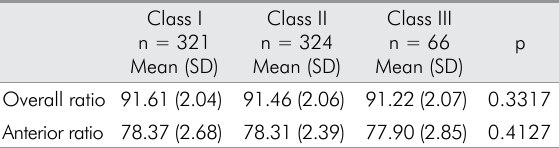
Table 4. Comparison of the overall and anterior ratios of tooth size discrepancies among malocclusion groups by one-way ANOVA test.